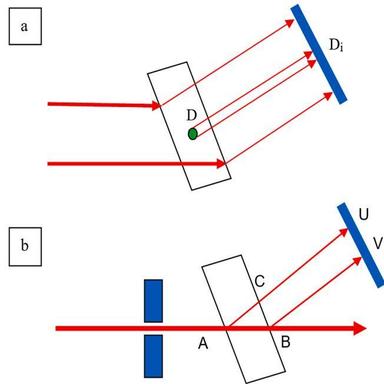
Bragg diffraction imaging (X-ray topography) (a) the platelet shaped crystal is set to be in Bragg position for a family of reflecting planes and the diffracted intensity is recorded on a two-dimensional detector with a spatial resolution in the μm range. A defect D can produce contrast within the recorded image (see text) (b) If the incoming beam width is reduced to ~10 μm we record a "section topograph".